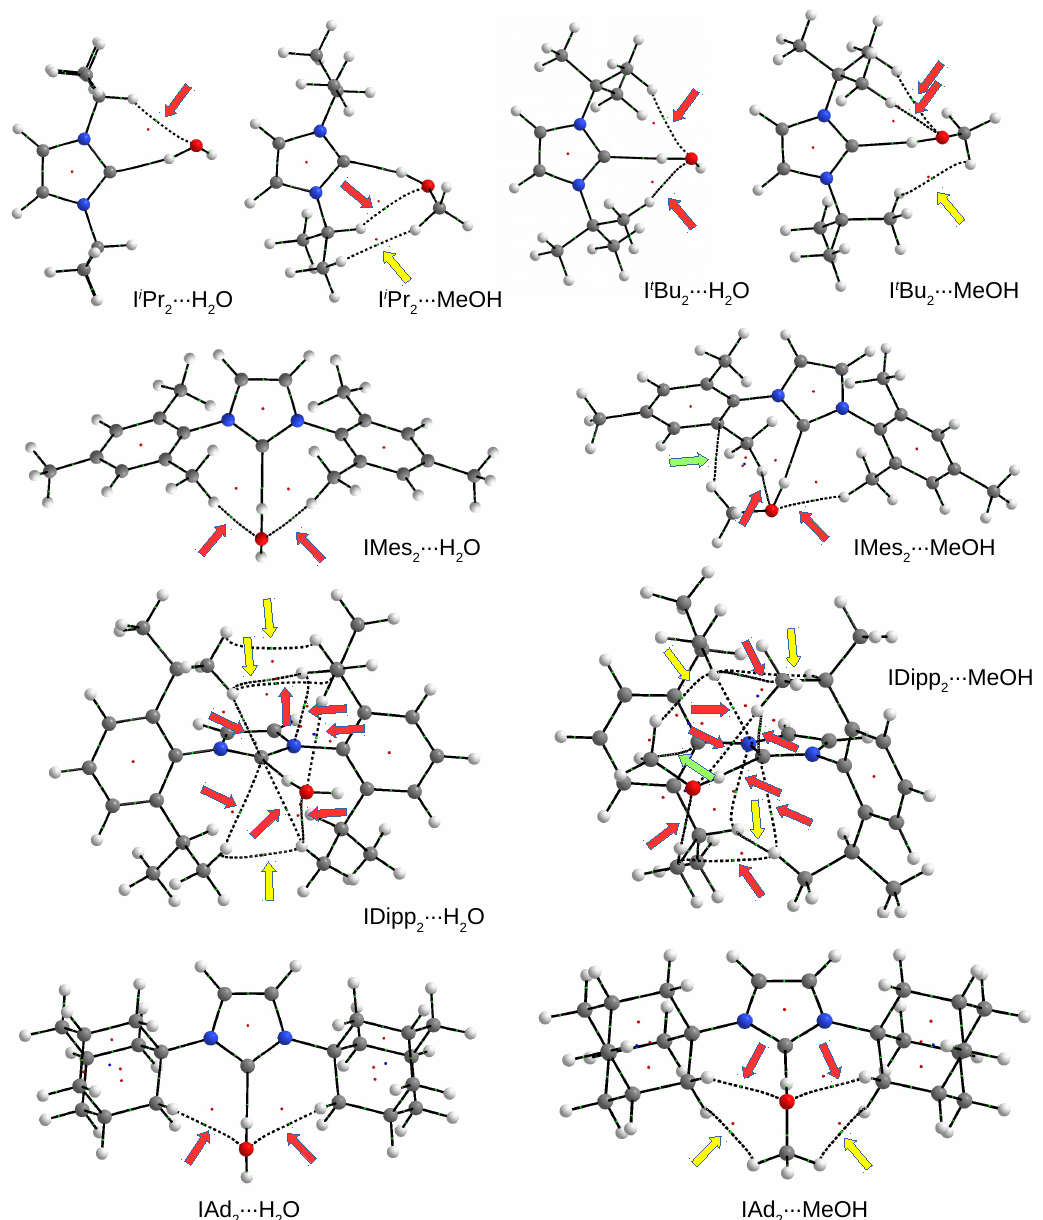
Figure 8. Molecular graphs of selected IR 2 · · · H 2 O and IR 2 · · · MeOH dimers. Arrows show the presence of bond paths for some accompanying interatomic interactions (hydrogen bonds—red, C- H · · · H-C contacts—yellow, and C-H · · · π hydrogen bonds—light green). Large balls represent atoms (hydrogen—white, carbon—gray, nitrogen—blue, and oxygen—red) and small balls represent critical points (bond critical points—light green, ring critical points—red, and cage critical